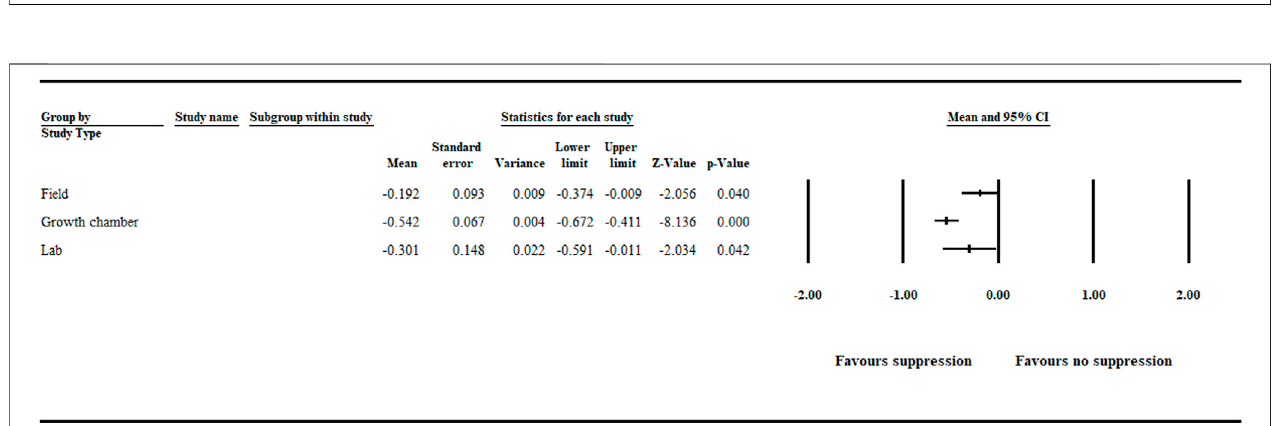
FIGURE5| Aseparate meta-analysison thebacterial treatmentcategoryindicates bacterial biocontrol agents withinthe genus Bacillus and Pseudomonas havea greateref fi cacycomparedwithothersinthesamecategory.Thecenterofthediamonddepictstheoverallmeaneffectsize,andthewidthre fl ectsitscon fi denceinterval. CI (cid:1) con fi dence interval. The Pseudomonas cepacia tested as a biocontrol agent in the Parke et al., 1991; and King and Parke, 1993 papers were included in the Burkholderia analysis, not in the Pseudomonas analysis.